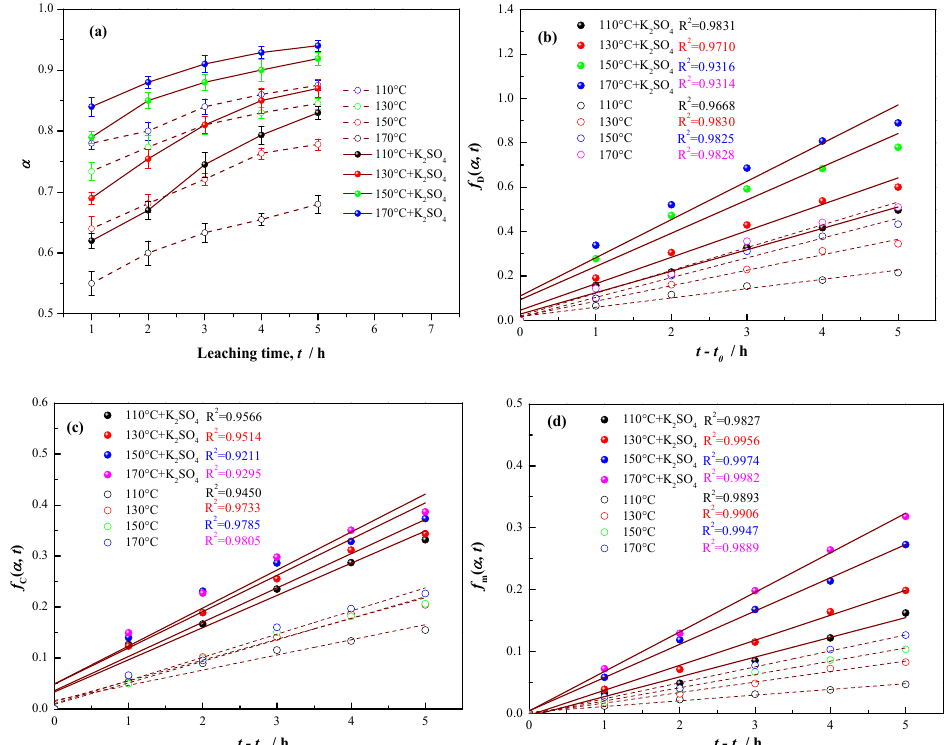
Figure 3. Variations of vanadium leaching e ffi ciency as a function of leaching time with acid concentration of 4 M and K 2 SO 4 dosage of 7 wt% at 110 ◦ C, 130 ◦ C, 150 ◦ C, and 170 ◦ C, respectively ( a ) and linear-fitting curves of Equations (2)–(4) ( b – d ) basing on the data in ( a ). The dashed lines and hollow points represent the vanadium leaching e ffi ciency and corresponding linear-fitting curves without K 2 SO 4 addition, other leaching parameters being